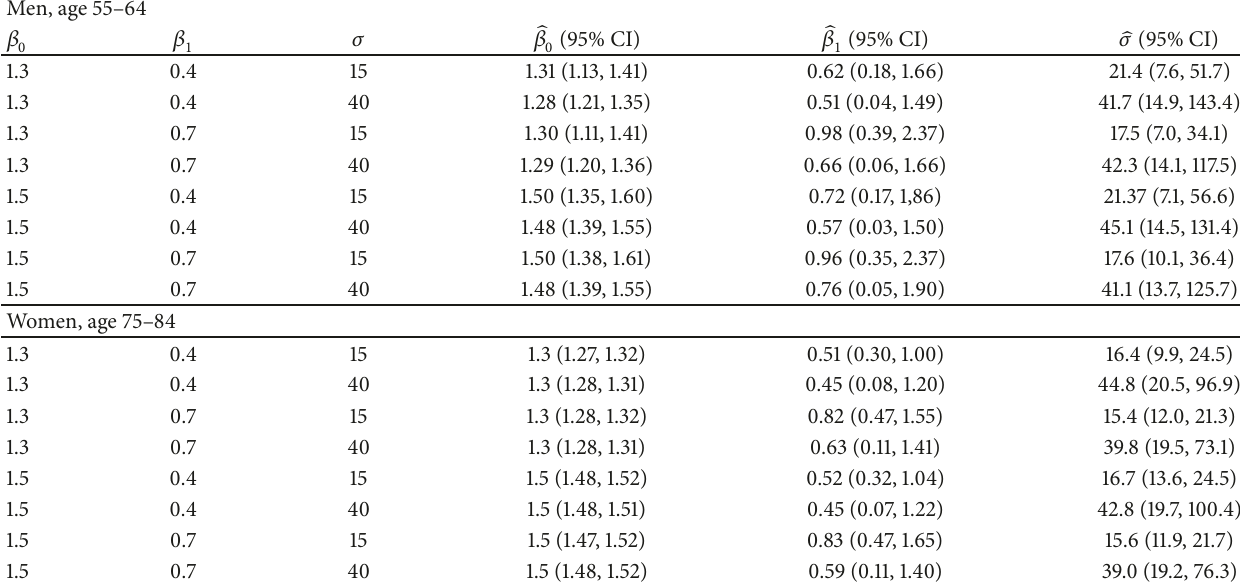
Table 3: Least square estimates based on simulated survival times from 𝑆(𝑡) in (4). Averaged estimates and confidence intervals (CI) from 1000 repetitions in two groups: men age 55–64 and women age